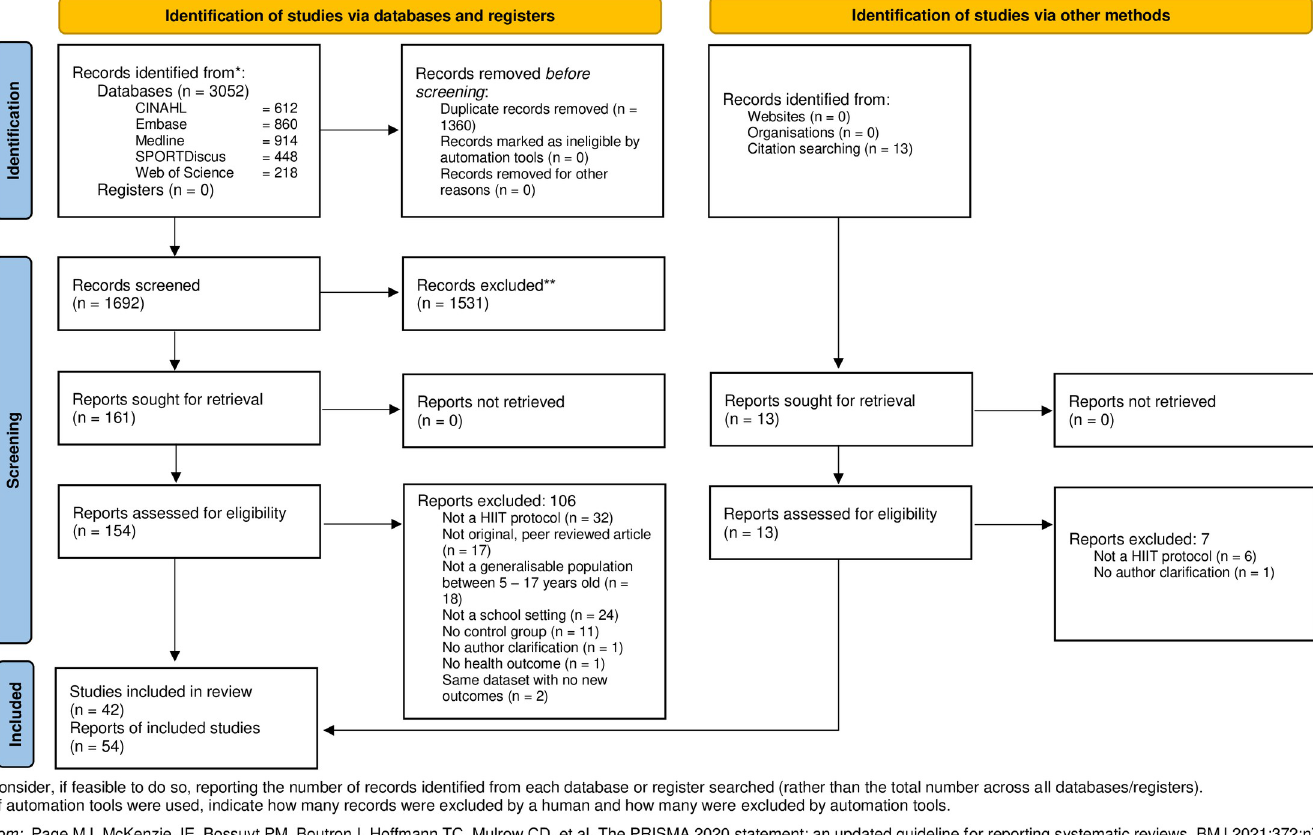
PLOS ONE | https://doi.org/10.1371/journal.pone.0266427 May 4,